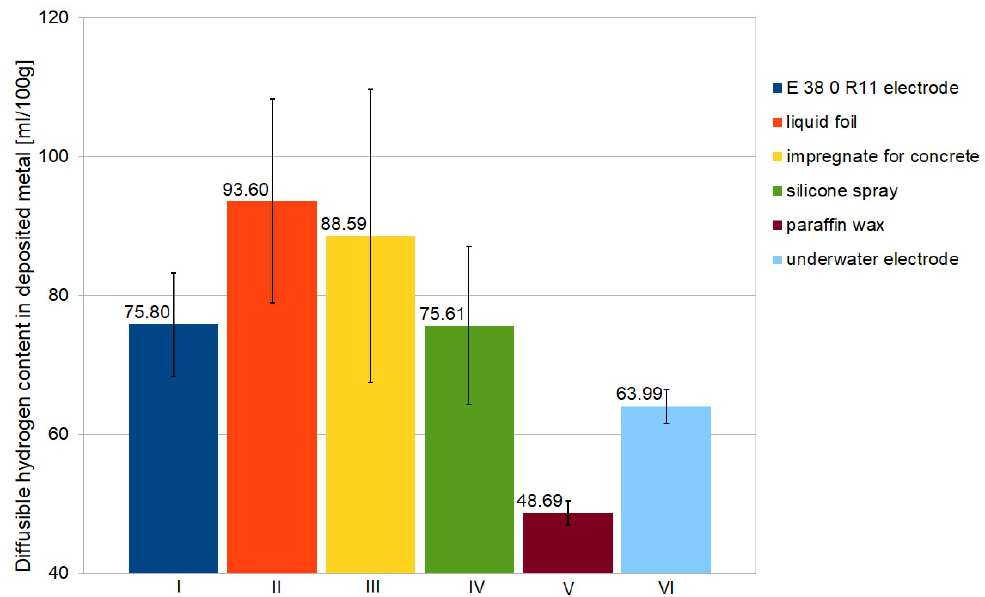
Figure 6. The average values of diffusible hydrogen content in deposited metal.